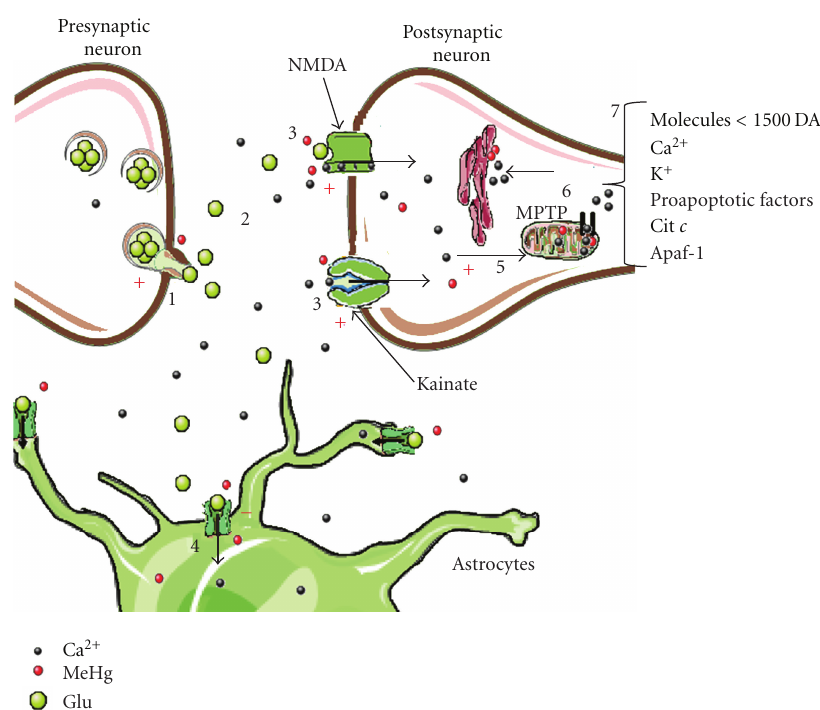
Figure 4: MeHg as mediator of neuronal toxicity via Ca 2+ -mediated excitotoxicity: (1) glutamate (Glu) release from presynaptic neuron induced by MeHg; (2) increase of Glu into synaptic cleft; (3) Ca 2+ influx via NMDA and Kainate receptors; (4) MeHg binds at Glu transporters in astrocytes; (5) mitochondria bu ff ering the excess of Ca 2+ intracellular; (6) MeHg causing mitochondrial and SER